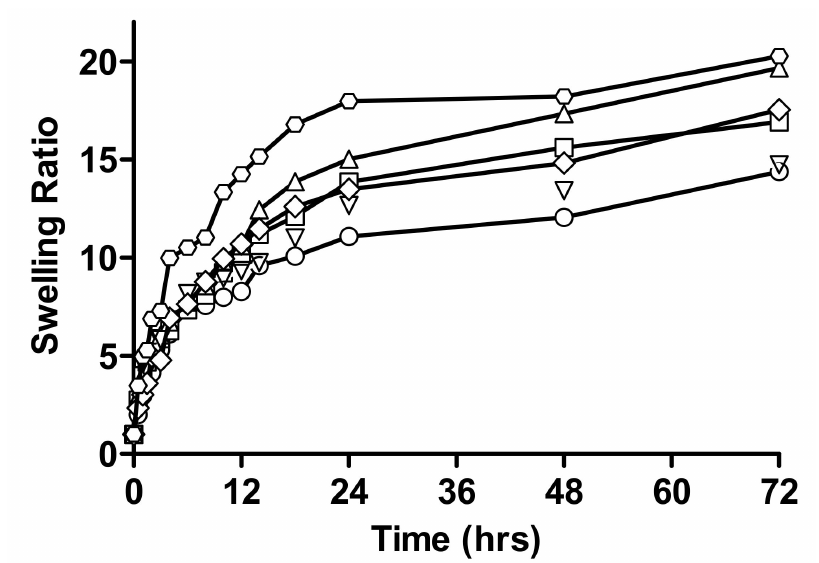
Figure 3. Relative swelling ratios of linseed-co-AAM graft copolymer hydrogels with varying linseed mucilage concentration;